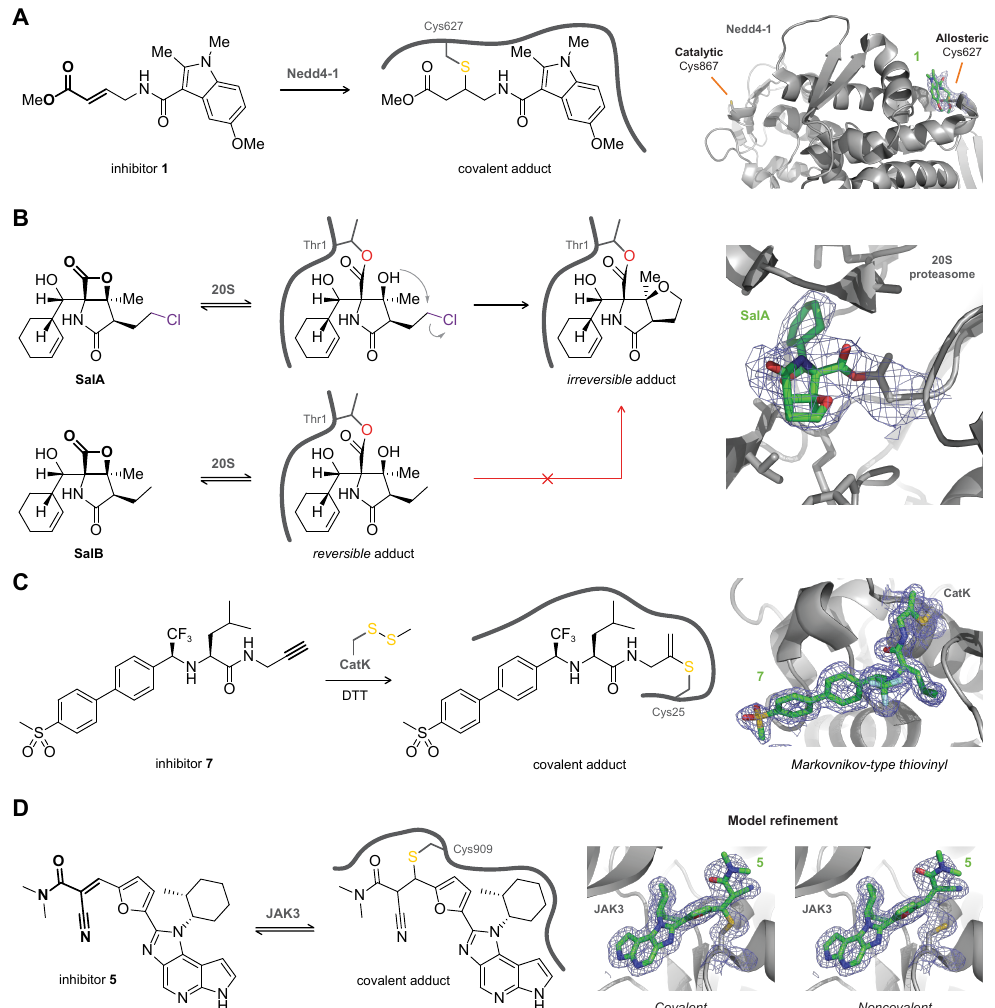
Figure 6. Structural binding information on covalent protein–drug adducts obtained by protein crystallography. ( A ) Identification of unexpected modified amino acid residue. Inhibitor 1 modifies ubiquitin E3 ligase Nedd4-1 on allosteric cysteine residue Cys627 rather than the more nucleophilic catalytic cysteine residue Cys867 (PDB: 5C91) [91]. ( B ) Protein crystallography of closely related 20S proteasome inhibitors salinosporamide A (SalA, NPI-0052, marizomib) and salinosporamide B (SalB) aids mechanistic understanding of their different binding modes [120]: SalA (PDB: 2FAK) [110] forms an irreversible adduct by ring closure with a chloride leaving group following the initial formation of the reversible covalent acyl ester with Thr1-OH. ( C ) Structural analysis confirms thiol–alkyne addition of catalytic Cys25 in human cathepsin K (hCatK) to the internal alkyne carbon on odanacatib derivative 7 (PDB: 6QBS) [82], forming a covalent adduct with a Markovnikov thiovinyl bond layout similar to the thioimidate adduct of hCatK with the odanacatib nitrile (PDB: 5TDI) [121]. ( D ) Refined electron density maps assuming covalent ligand binding (left) or noncovalent ligand binding (right) indicate a mixture of both states upon co-crystallization of reversible covalent cyanoacrylamide 5 with Janus kinase JAK3 (PDB: 5LWN)